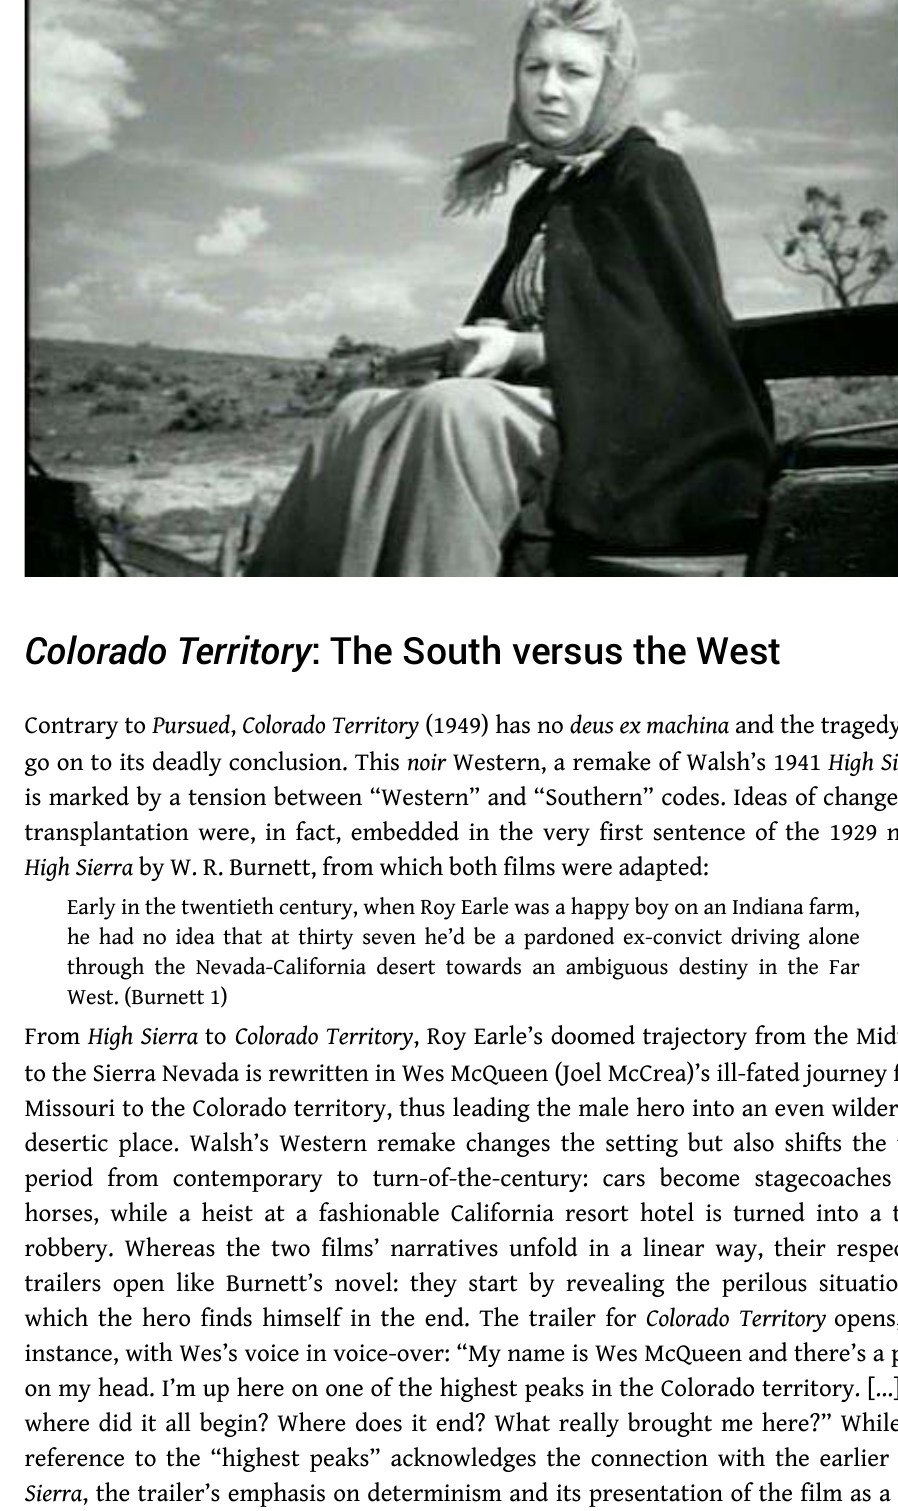
Figure 8: Mrs Callum saving the day in Pursued, gun in hand